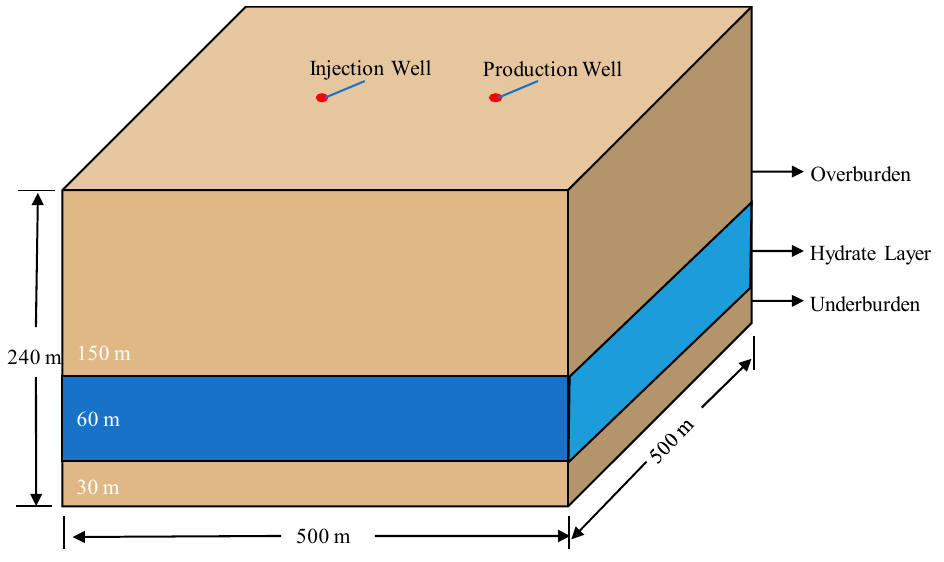
Figure 3. Schematic diagram of the geological model.